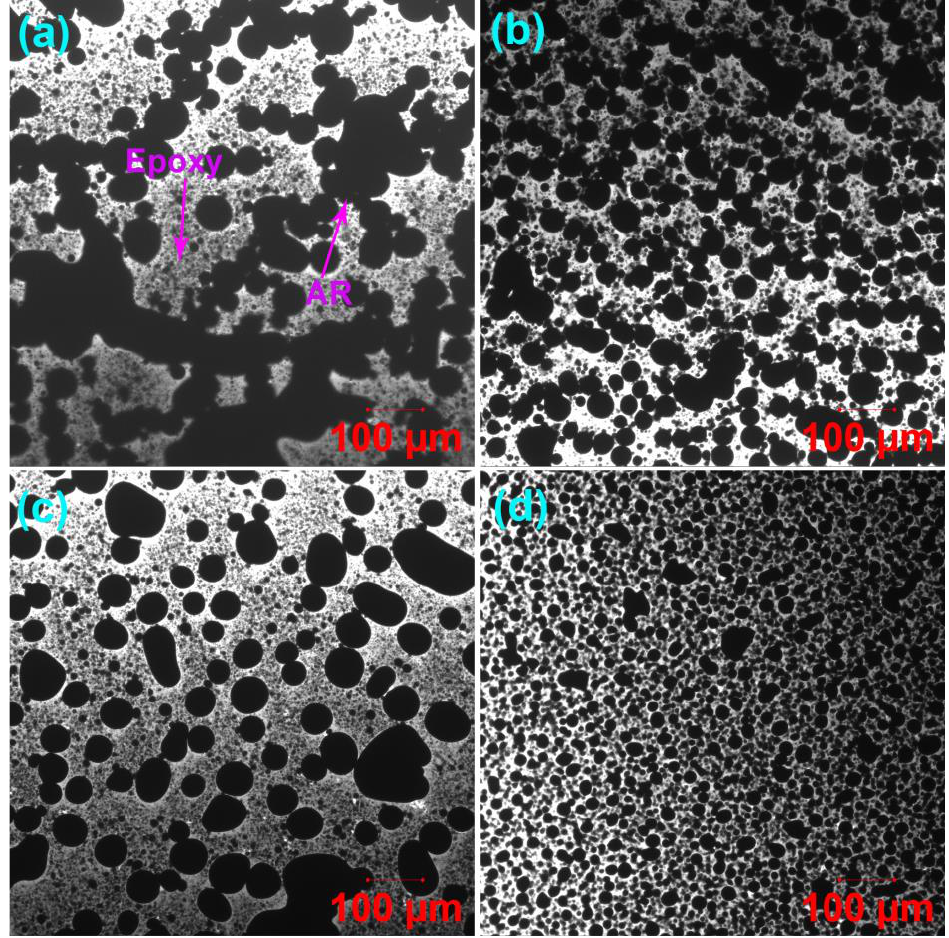
Figure 9. Transmission laser confocal microscopy images of ( a ) the unmodified EAR binder and modified EAR binders containing different WCO concentrations: ( b ) 2%, ( c ) 4% and ( d ) 6%.